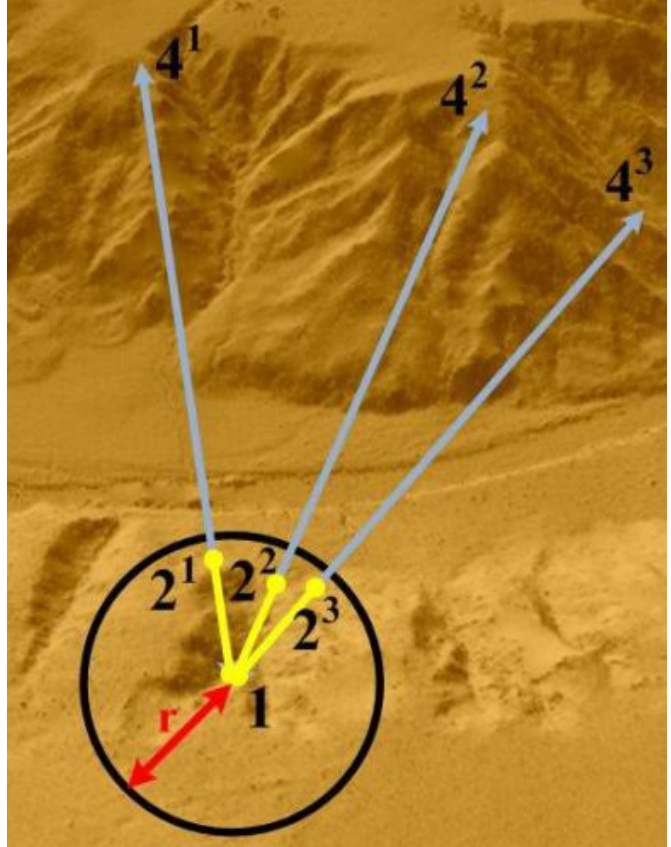
Figure 4. Constructed rays (1-4 1 , 1-4 2 , 1-4 3 ) with the length corresponding to the parameter of the maximal width defined by the DTM point under consideration (point 1) and points classified as potential candidates for the second characteristic points (2 1 , 2 2 , 2 3